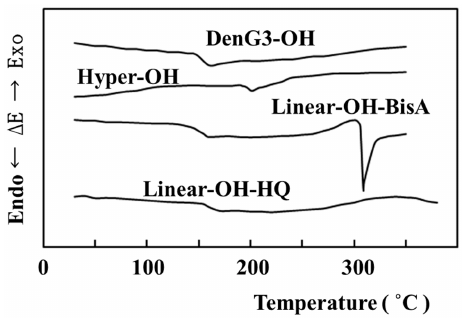
Figure 6. DSC curves of DenG3-OH , Hyper-OH , Linear-OH-BisA , and Linear-OH-HQ .